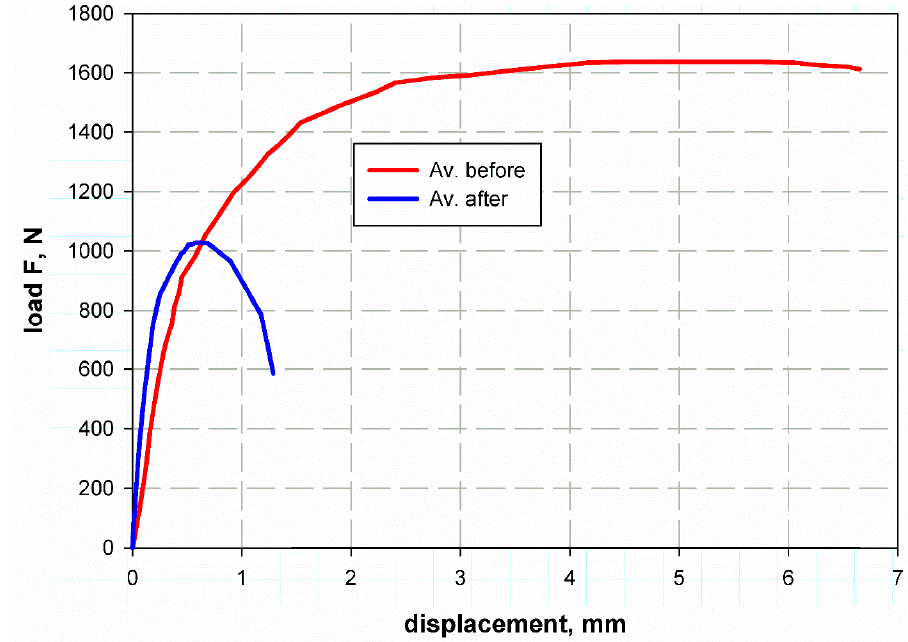
Figure 13. SENB specimen load-displacement curve.